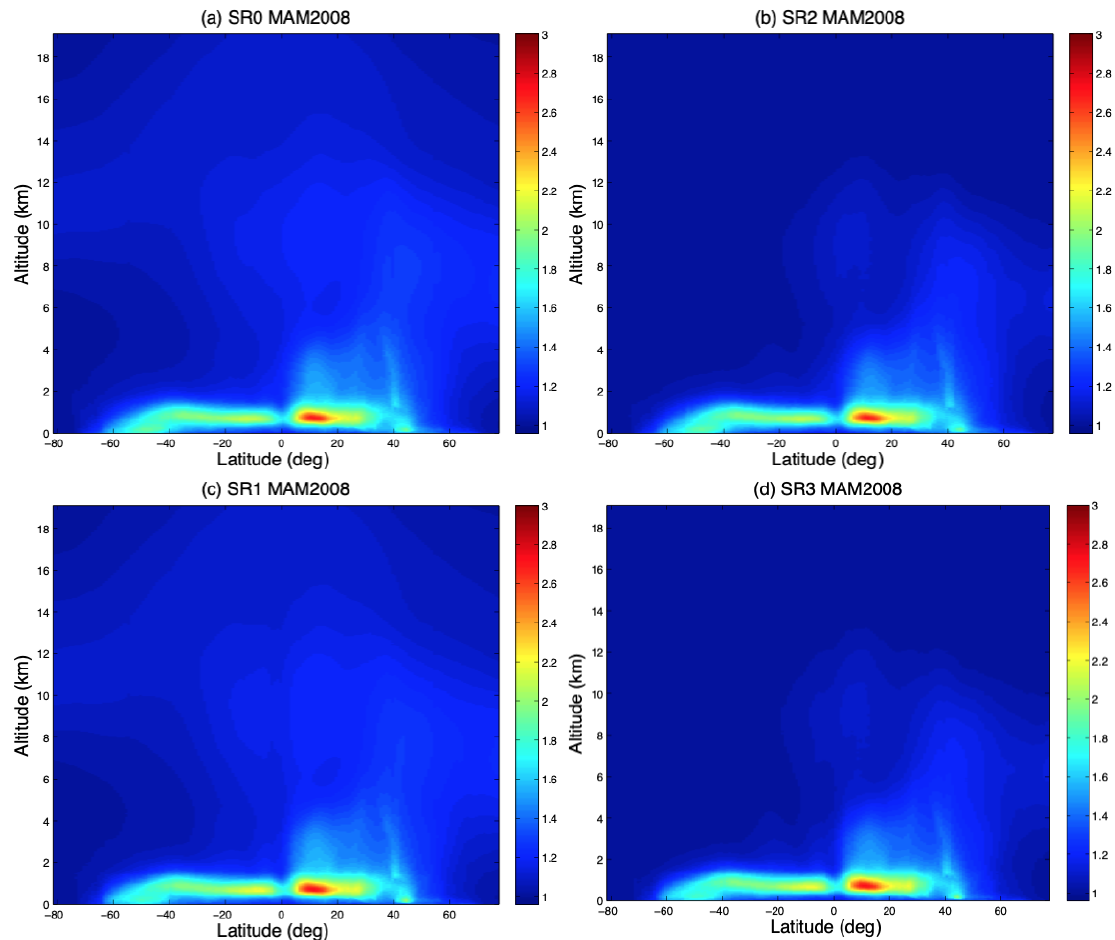
Figure 8. SR profiles simulated by E3SMv1 at 532nm and averaged over longitudes and time during MAM 2008: (a) initial profiles; (b) profiles with the instrument aerosol detection threshold; (c) cloud-screened profiles; (d) cloud-screened profiles with the aerosol detection threshold